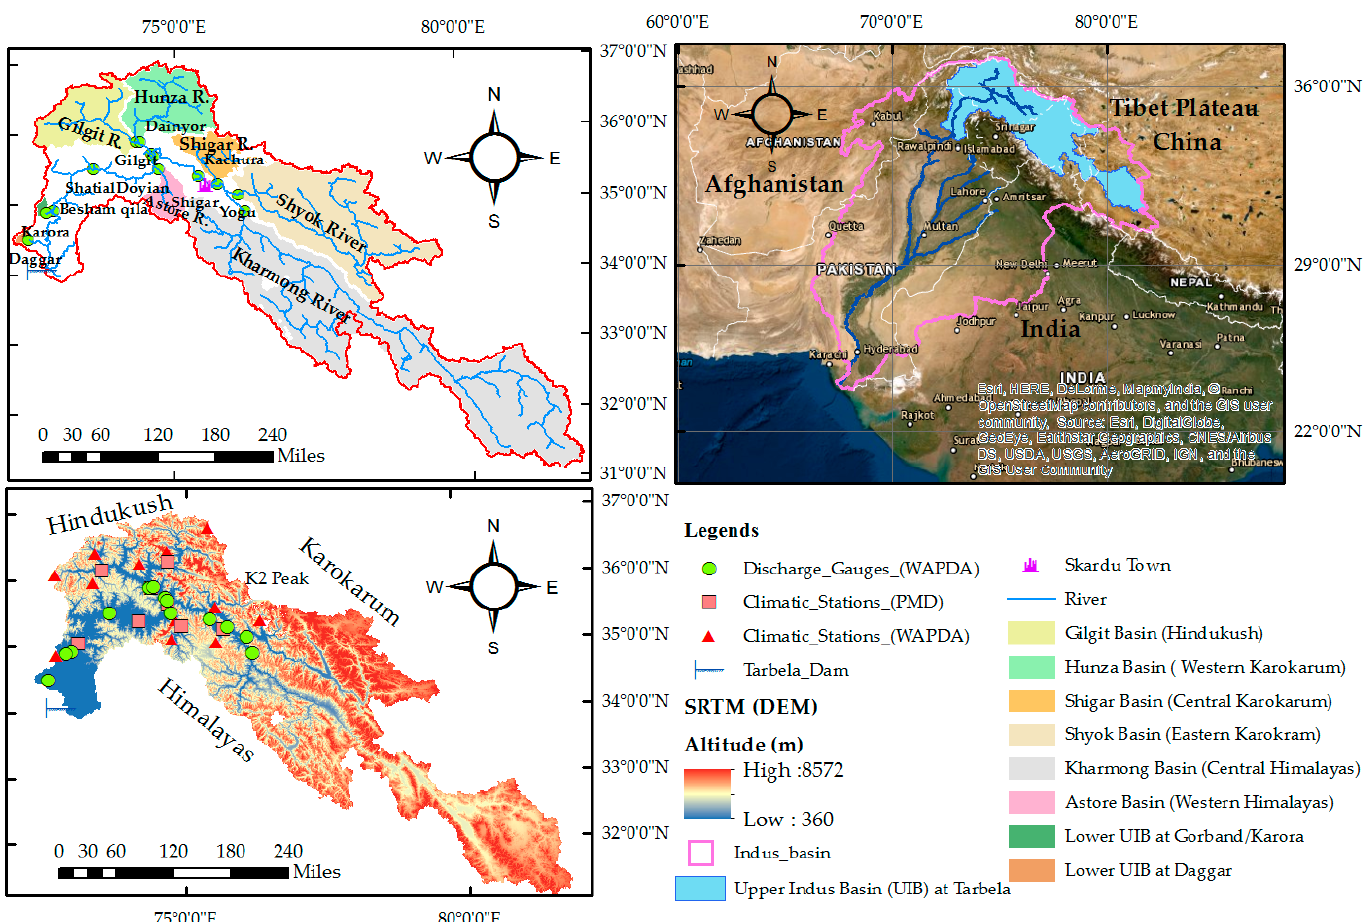
Figure 1. The map of the study area shows the locations of stream gauges, climatic stations, and sub-basins contributing to the Upper Indus Basin